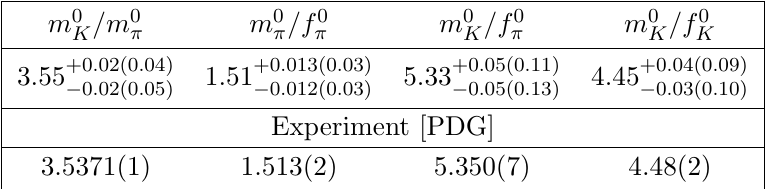
Table 9 . In the (cid:12)rst row, the values of the ratios of pseudoscalar masses and decay constants extrapolated to the physical point for Fit IV. The uncertainties quoted should be interpreted in terms of probability. The central value represents the median, the (cid:12)rst upper and down indices gives the 68% CI, while the sum of the absolute values of the two upper (down) indices provides the upper (down) limits of the 95% CI. The experimental values are shown in the second row [3].